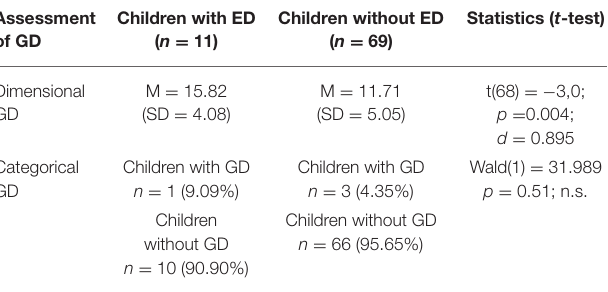
TABLE 6 | Differences between children with emotional dysregulation and children without emotional dysregulation on dimensional and categorical assessment of gaming